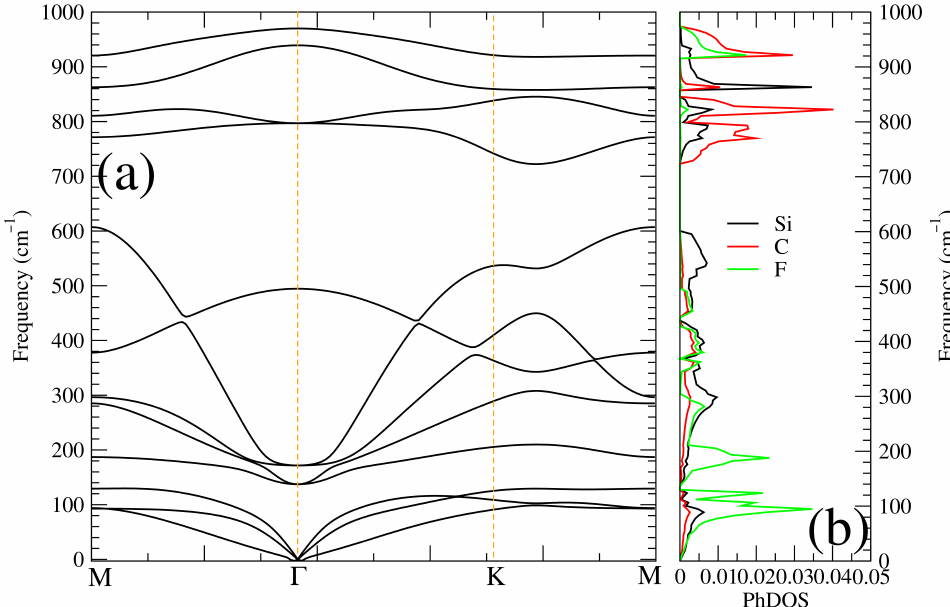
Figure 3. ( a ) Phonon dispersion plot and its corresponding ( b ) phonon density of states of CF 2 Si monolayer in cm − 1